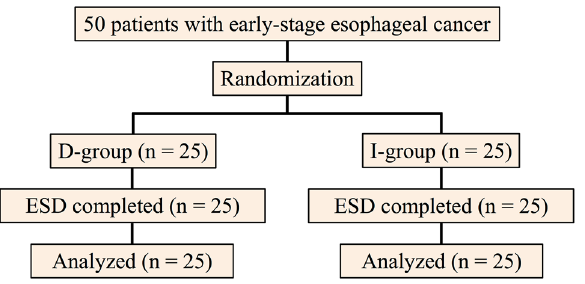
Figure 2. Study flowchart showing patient inclusion and randomization. D-group DualKnife group, I-group ITknife nano group, ESD endoscopic submucosal dissection.